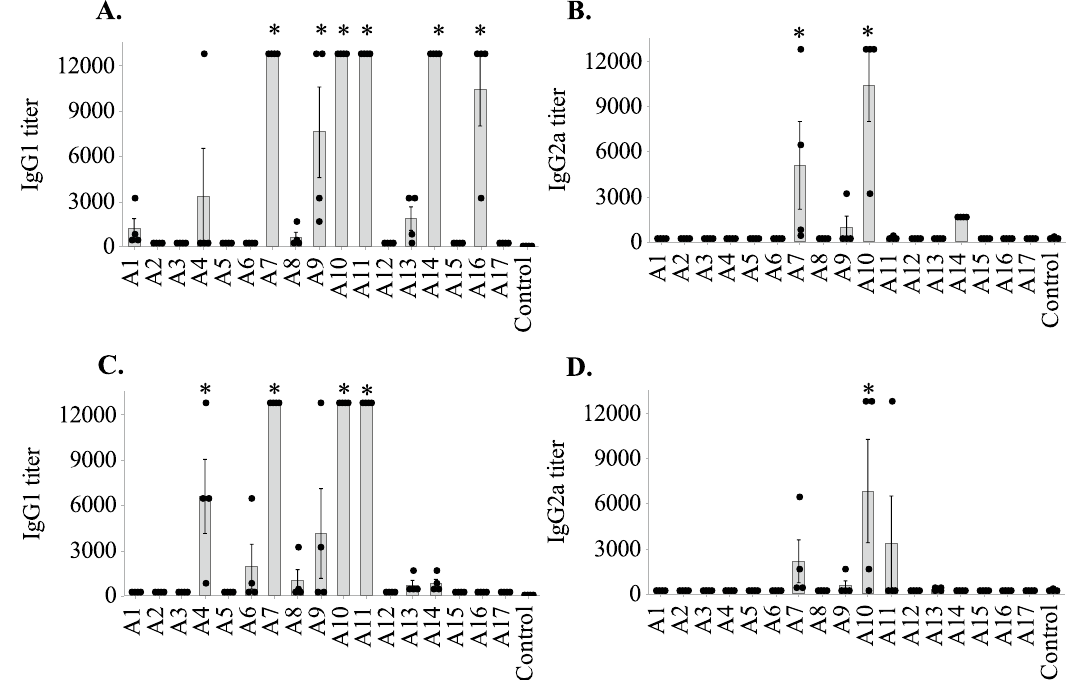
Figure 2. IgG1/IgG2a titers in mice vaccinated with the peptides and the recombinant AdLP-D1 protein. Mouse sera were tested for the presence of peptide-specific antibodies and their ability to bind to the recombinant AdLP-D1 protein. Individual data points are represented as black dots, while bars represent the geometric mean (± SE) of sera from four mice vaccinated with each peptide (A1 to A17). ( A , B ) antibody titers against the respective peptides used for the vaccination. ( C , D ) Antibody titers against the recombinant protein. Significance differences to the control (adjuvant only) group are shown as * P <